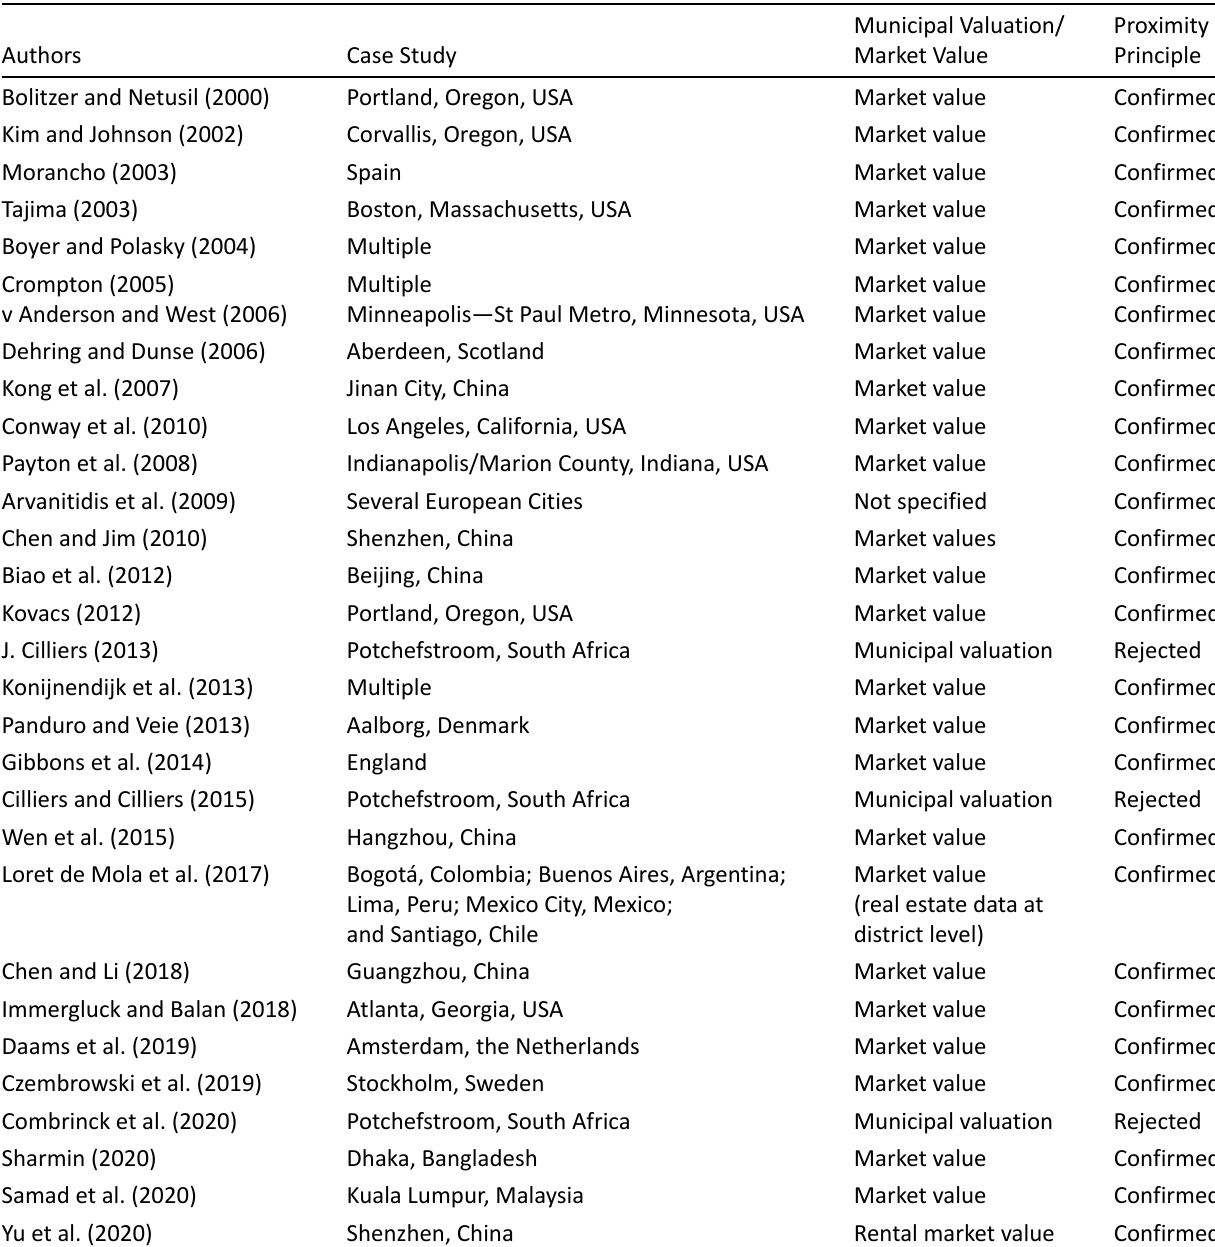
Table 2. Selected studies employing the